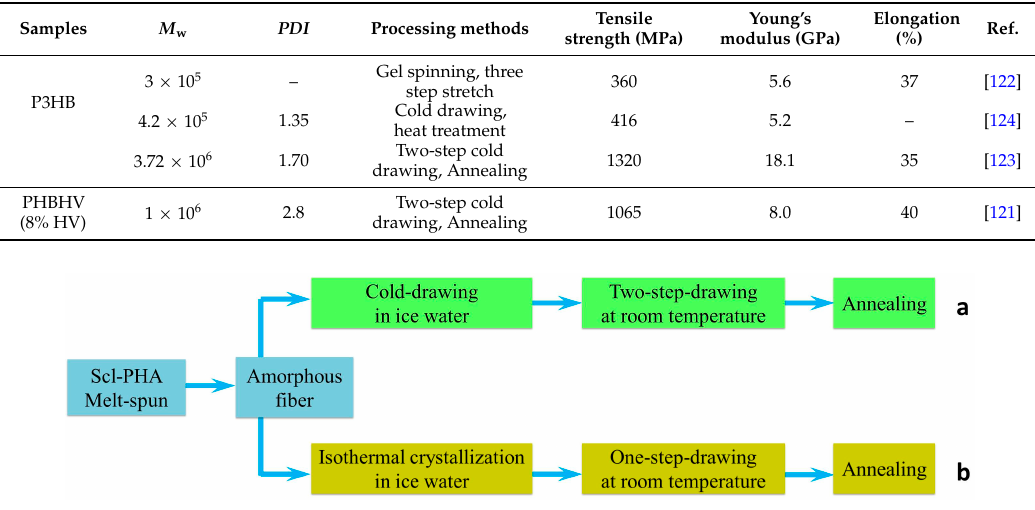
Figure 10. Preparation methods for PHA fibers: ( a ) One-step drawing without isothermal crystallization and ( b ) One-step drawing after isothermal crystallization. Reprinted with permission from [121]. Copyright 2006 American Chemical